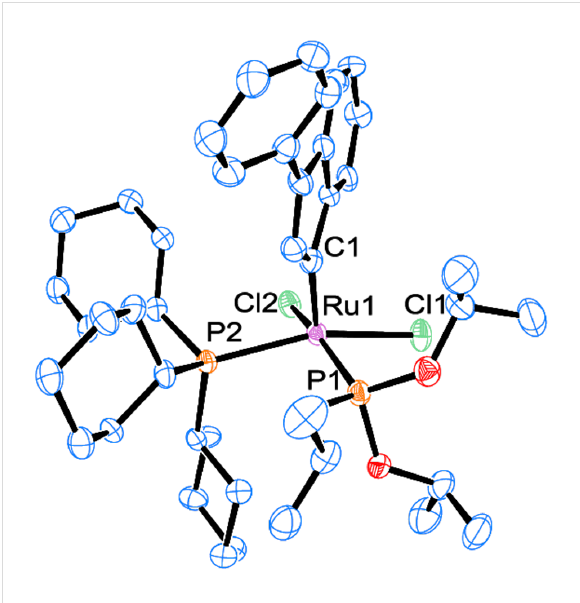
Figure 2: Molecular structure of mixed phosphine/phosphite complex 1 . Hydrogen atoms are omitted for clarity.